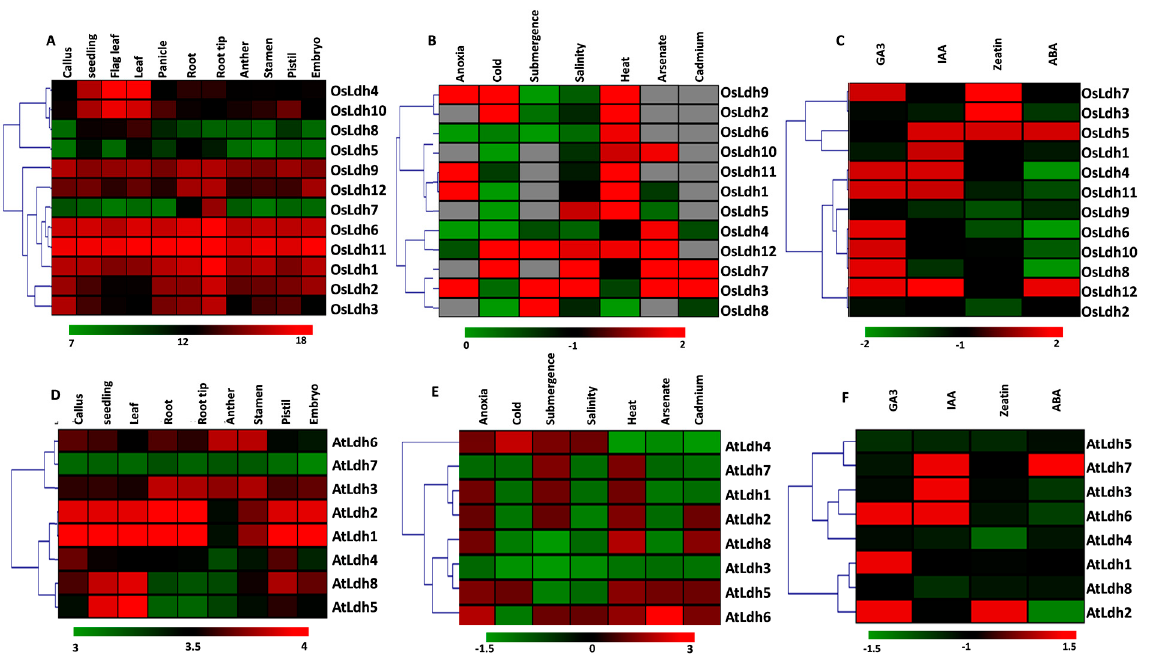
Figure 4. Tissue–specific and stress induced expression profiling of Ldh transcripts in rice and Arabidopsis . Normalized transcript data of OsLdh and AtLdh genes were obtained for ( A , D ) different tissues and ( B , E ) under different stress conditions and ( C , F ) hormone treatment as retrieved from the publicly available Genevestigator database. The fold change in expression has been shown as a heatmap generated using the MeV software package. Colour scale below the heatmap shows the level of expression. Hierarchical clustering has been performed on the basis of similarity in expression profiling. Grey colour denotes non-availability of data.